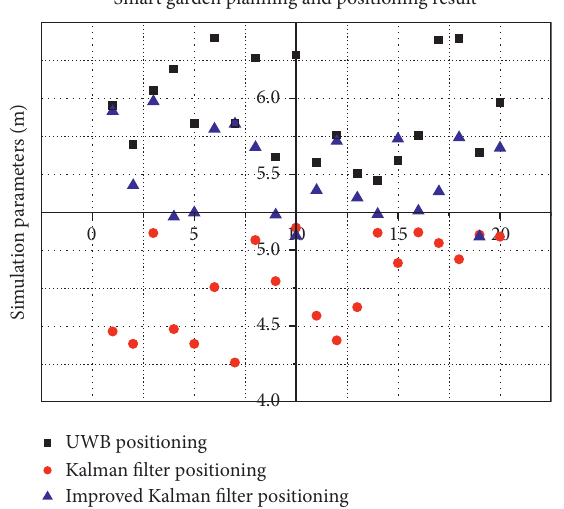
Figure 4: Positioning trajectory map.